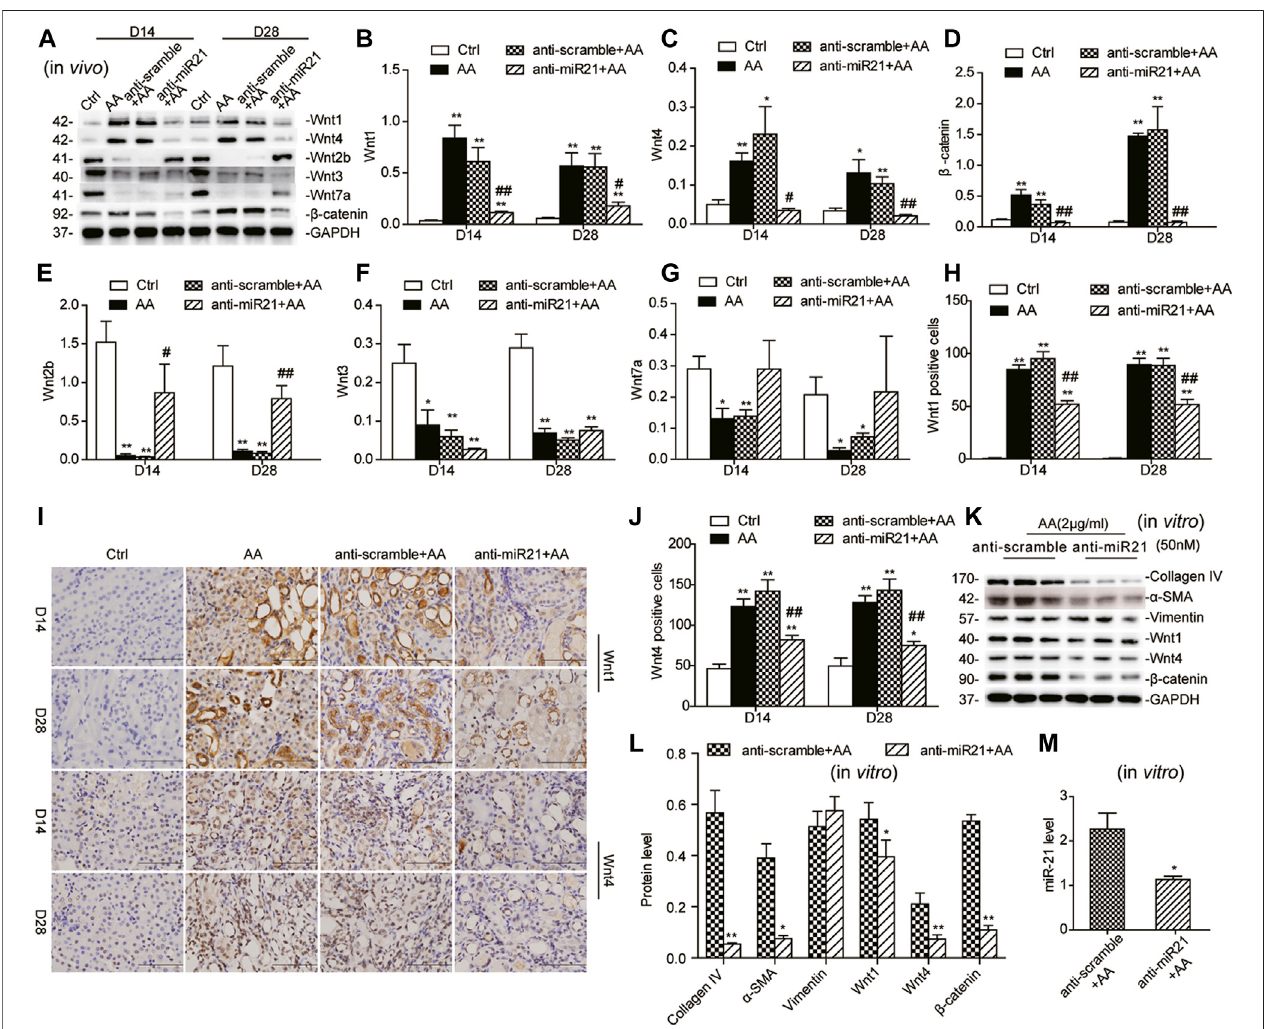
FIGURE 3 | Inhibition of miR-21 selectively suppresses Wnt/ β -catenin signaling in vivo and vitro. (A – G) Western blots and quantitative data of renal expression of Wnt1,Wnt2b, Wnt3, Wnt4, Wnt7a, and β -catenin on days 14 and 28 after AAdelivery. LNA-modi fi ed anti-miR21 oligonucleotides or anti-scramble was administered to themiceviathetailvein(10 mg/kg,5 mg/ml)within60 minpriortoAAdelivery.Additionalinjections(thesamedose)weregivenonthe5 th and10 th dayafterAA-Idosing. (H – J) Immunohistochemical staining of Wnt1 and Wnt4 in the kidneys (magni fi cation, 400 × , bar (cid:2) 200 μ m) and the number of Wnt1/Wnt4 positive cells in the mouse kidneys. * p < 0.05, ** p < 0.01 vs. controls. # p < 0.05, ## p < 0.01 vs. anti-scrambled control groups, n (cid:2) 6. (K – M) Changes in protein abundances of collagen IV, α -SMA, vimentin, Wnt1, Wnt4, and β -catenin and miR-21 abundance in HK-2 cells. HK-2 cells were pretreated with 50 nM anti-miR21 or 50 nM anti-scramble 6 h prior to 48 h-AA treatment (2 μ g/ml). * p < 0.05 and ** p < 0.01 vs. anti-scramble controls, n (cid:2) 3.